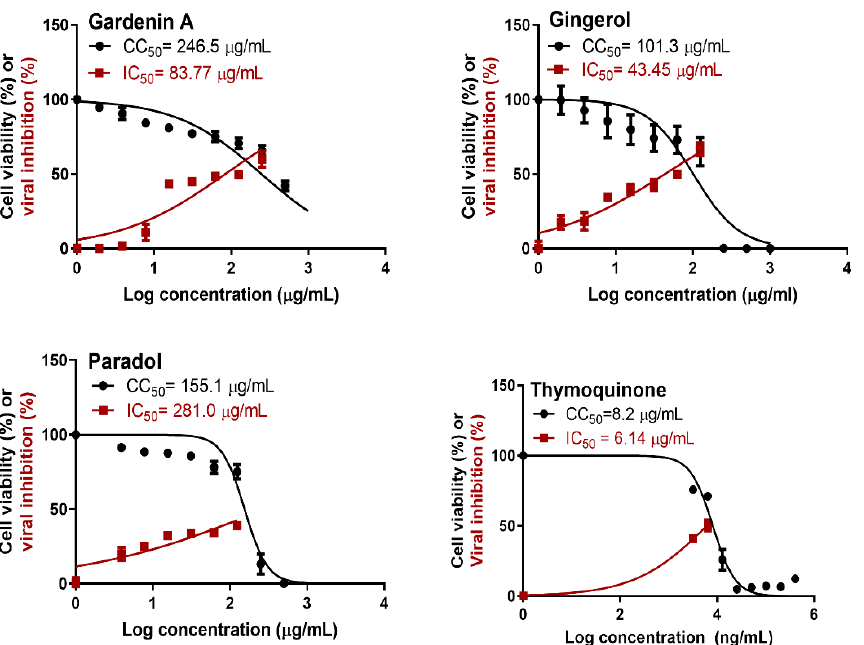
Figure 3. Dose-inhibition curves for bioactive compounds, where IC50 values were calculated using nonlinear regression analysis of GraphPad Prism software (version 5.01) by plotting log inhibitor versus normalized response.